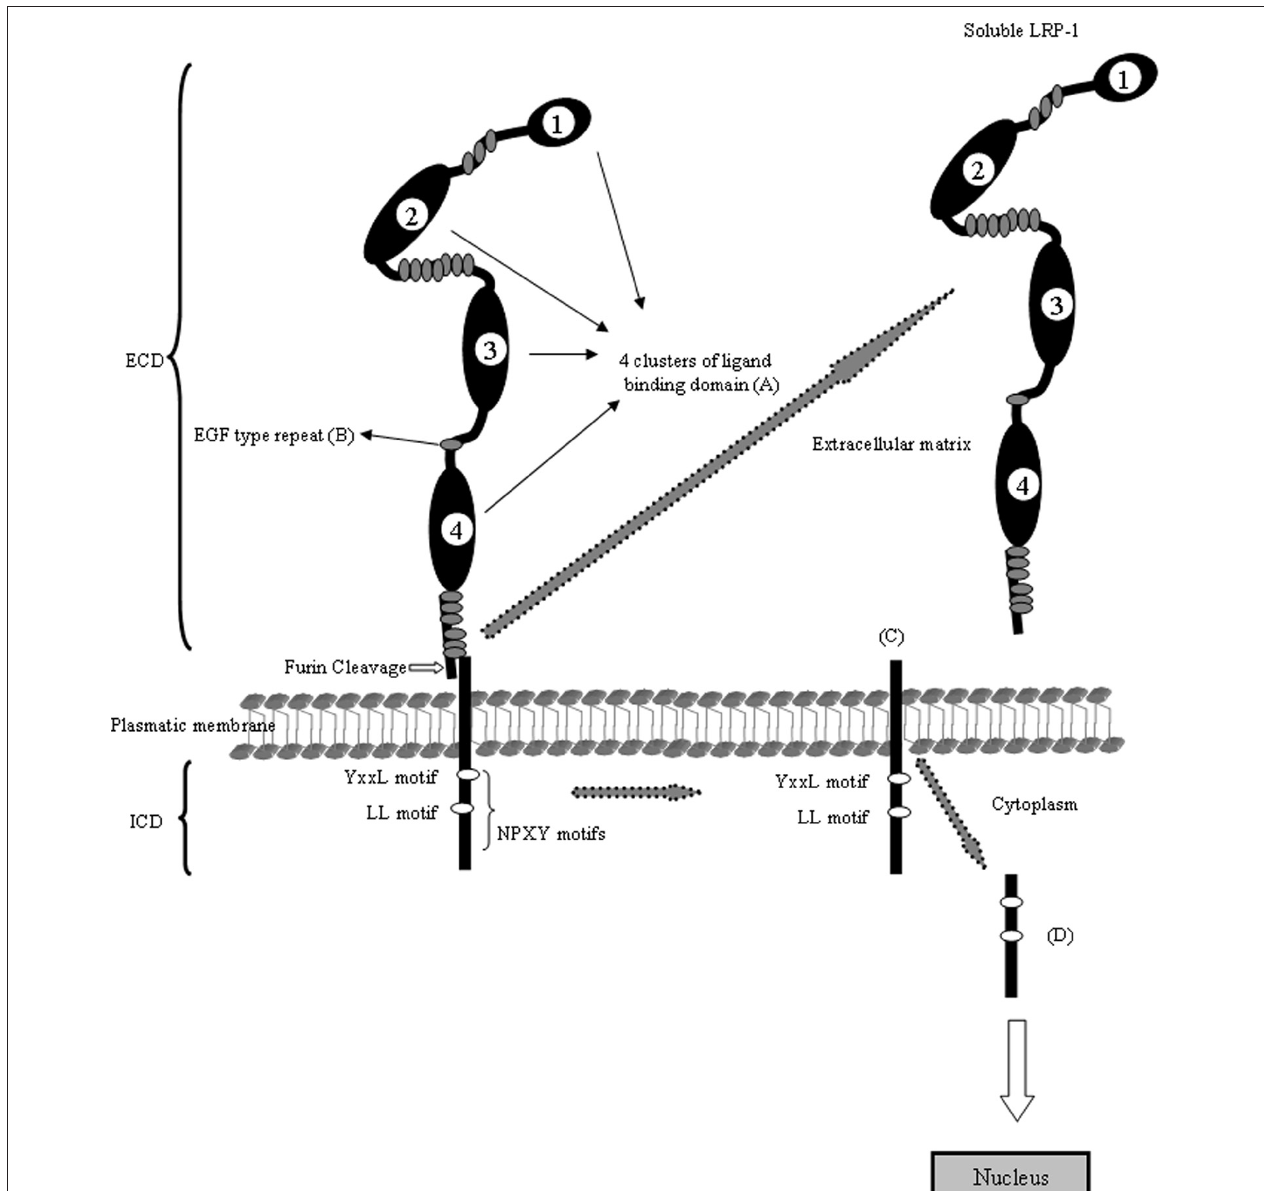
FIGURE 1 | Schematic domain organization of LRP1. The LRP1 contains five different domains: (A) the ligand-binding domain, (B) the EGF-precursor homology domain, (C) the O-linked sugar domain, (D) the transmembrane domain and (E) the intracellular domain. The ligand-binding domain consists of four clusters and mediates the binding to ligands (see Table 1 ). The hydrophobic transmembrane domain ensures the anchoring the LRP1 in the plasma membrane. The cytoplasmic tail of the LRP1 containing the characteristic NPXY sequence interact with phospho-tyrosine binding domains of cellular adaptors proteins which are important for endocytosis and